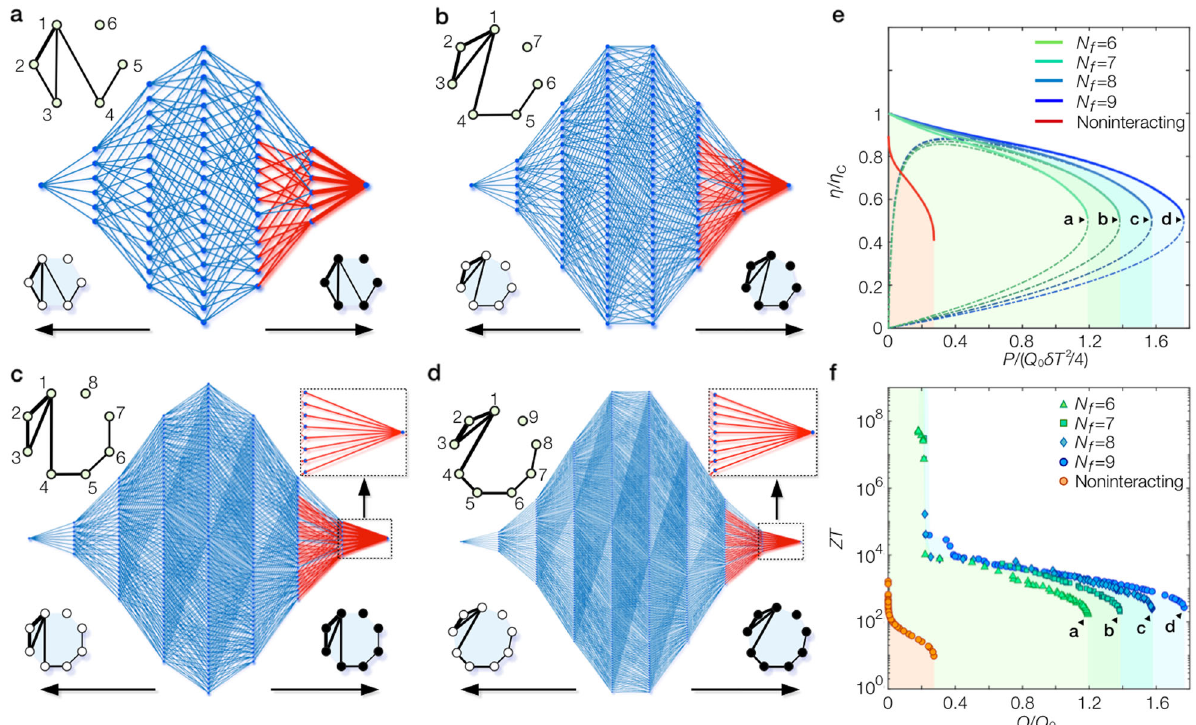
Fig. 4 Size dependence of the highest-power nanoscale heat engine. a – d Topologies of the interaction networks (insets) and the state-transfer networks (main panels) for the highest-power heat engines with a 2 N f ¼ 64, b 128, c 256, and d 512 states. The red edges in the state-transfer networks indicate the activated transfer edges associated with signi fi cant probability fl ows. The interaction networks are optimized such that single-hole excitation energies are degenerate and its topology is sparse as much as possible. The former leads to the activation of all the transfer edges between the fully occupied state and single-hole states (see also magni fi ed insets in c and d ). The latter eliminates unfavorable interactions among hole excitations, leading to the maximal activation of transfer edges between single-hole states and double-hole states. Here, the white and black nodes represent the empty and occupied levels, respectively, and the thickness of links indicates the strength of interaction. e The best trade-offs between power P and ef fi ciency η for the highest-power heat engines at different system sizes N f . f The corresponding Pareto fronts in terms of power factor Q and fi gure of merit ZT . In e , f , the allowed regions (color shaded with the upper bounds indicated by the solid curves) expand with increasing N f . The dashed curves represent the ef fi ciency-power curves for the maximum-power machines. The data of the noninteracting case for N f = 9 with the same set of (nondegenerate) single-electron levels as used in the interacting case are given in e , f . We set ϵ l = l Δ with Δ / k B T = 3, γ h = γ c ≡ γ , and plot Q in the unit of Q 0 = k B γ / T . The ef fi ciency and power factor are normalized by η C and Q 0